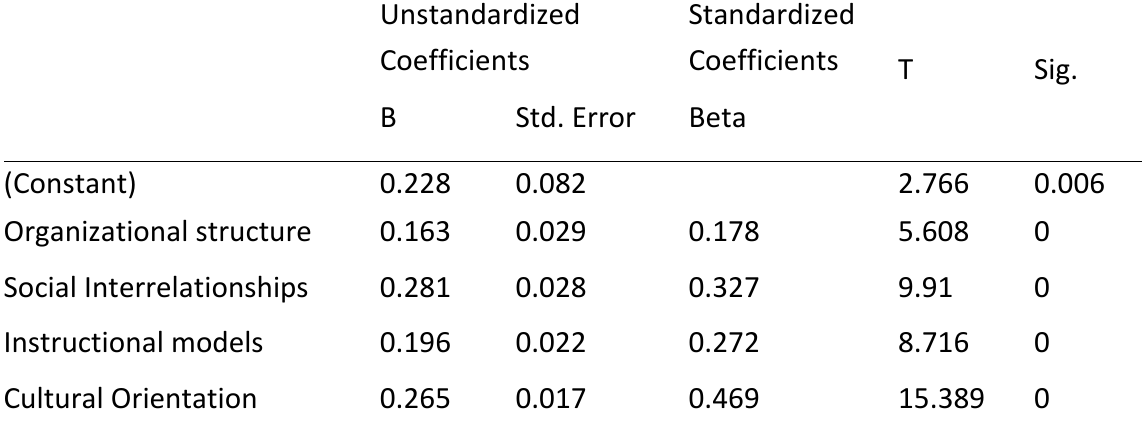
Table 13. Regression